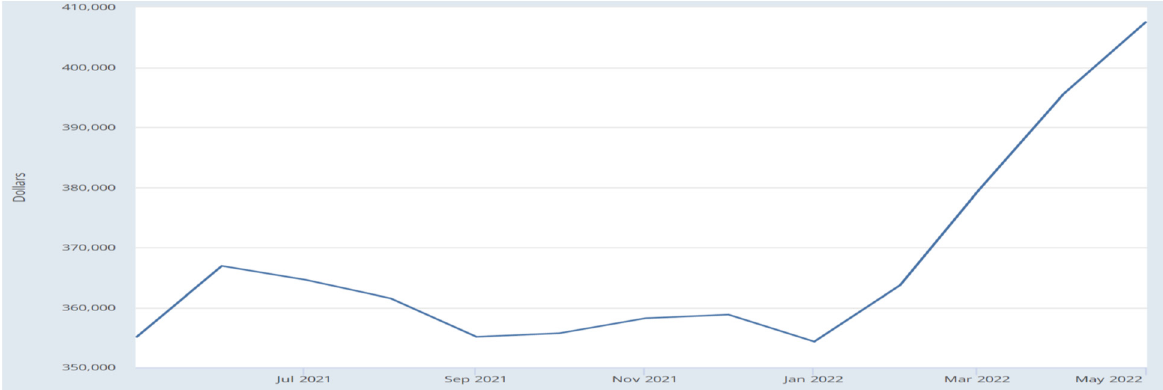
Figure 8. Median Sales Price of Existing Home. Source: National Association of Realtors.